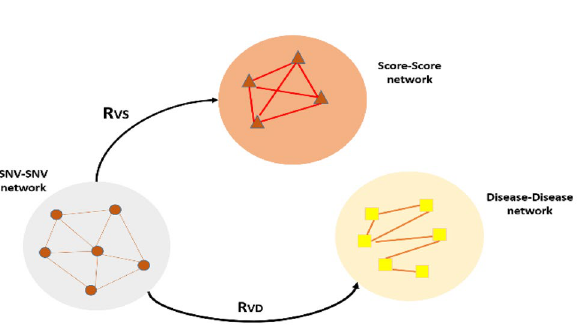
Figure 2. Configuration of our method for three types of data sources. R VD associates SNV-SNV and Disease- Disease networks. R VS shows the relation matrix which connects SNV-SNV and Score-Score networks. The figure is created using Microsoft PowerPoint